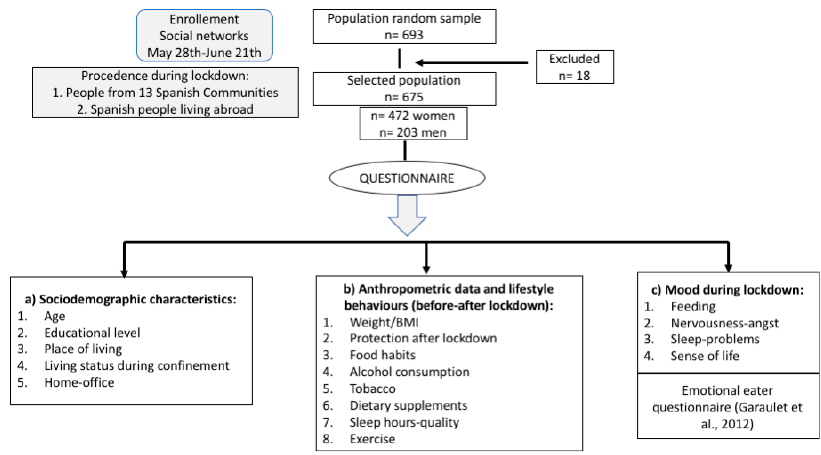
Figure 1. Flow chart of the study participants and blocks of the electronic questionnaire.